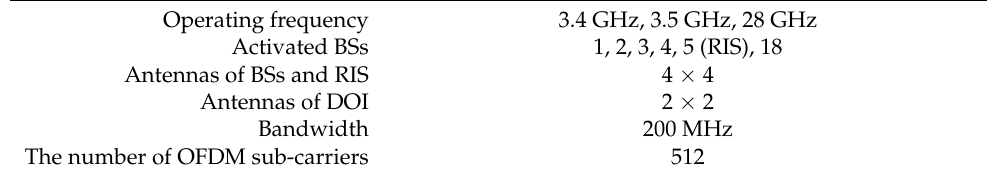
Table 1. DeepMIMO settings for our experiments.